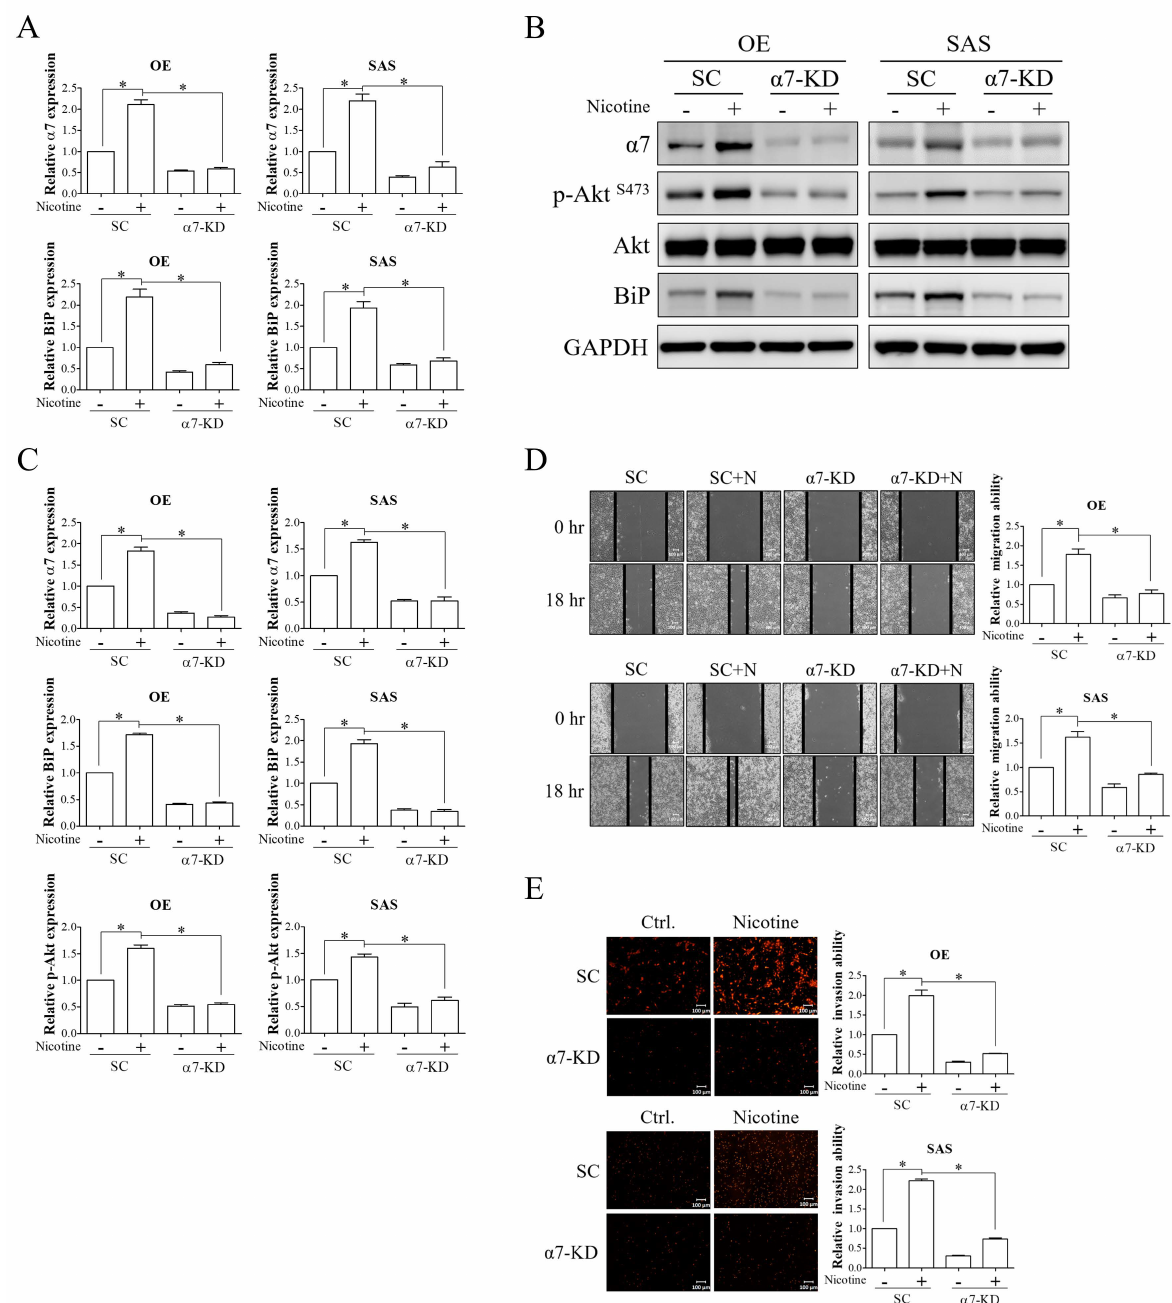
Figure 3. α 7-nAChR-Akt signaling was involved in nicotine-induced BiP expression and malignant behaviors in OSCC. OE and SAS cells with/without α 7-nAChR silencing were treated with 1 µ M nicotine for 48 h. ( A , B ) The expressions of α 7-nAChR and BiP and activation of Akt, as indicated by the expression level of phospho-Akt at Ser473, were analyzed by quantitative RT-PCR and Western blot analysis. ( C ) The graphs show the quantification of Western blots. Band intensities were quantified using ImageJ software. The relative protein expressions of α 7-nAChR and BiP were normalized to GAPDH expression. The relative protein expression of phospho-Akt (Ser473) was normalized to total Akt expression. The migratory ( D ) and invasive ( E ) abilities were examined by wound healing and Transwell invasion assays. Representative images